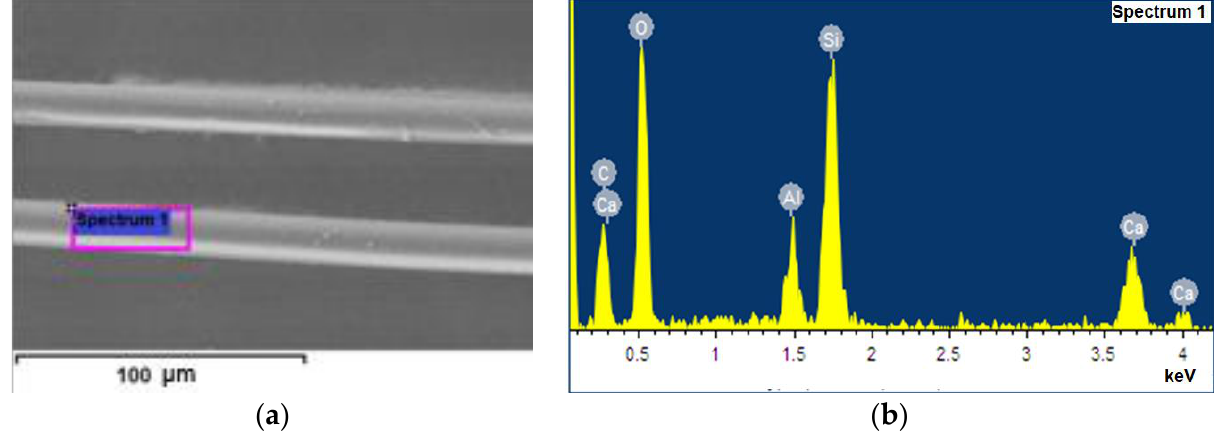
Figure 1. The microstructure of the pure glass fiber surface ( a ) and the corresponding EDA spectrum ( b ).